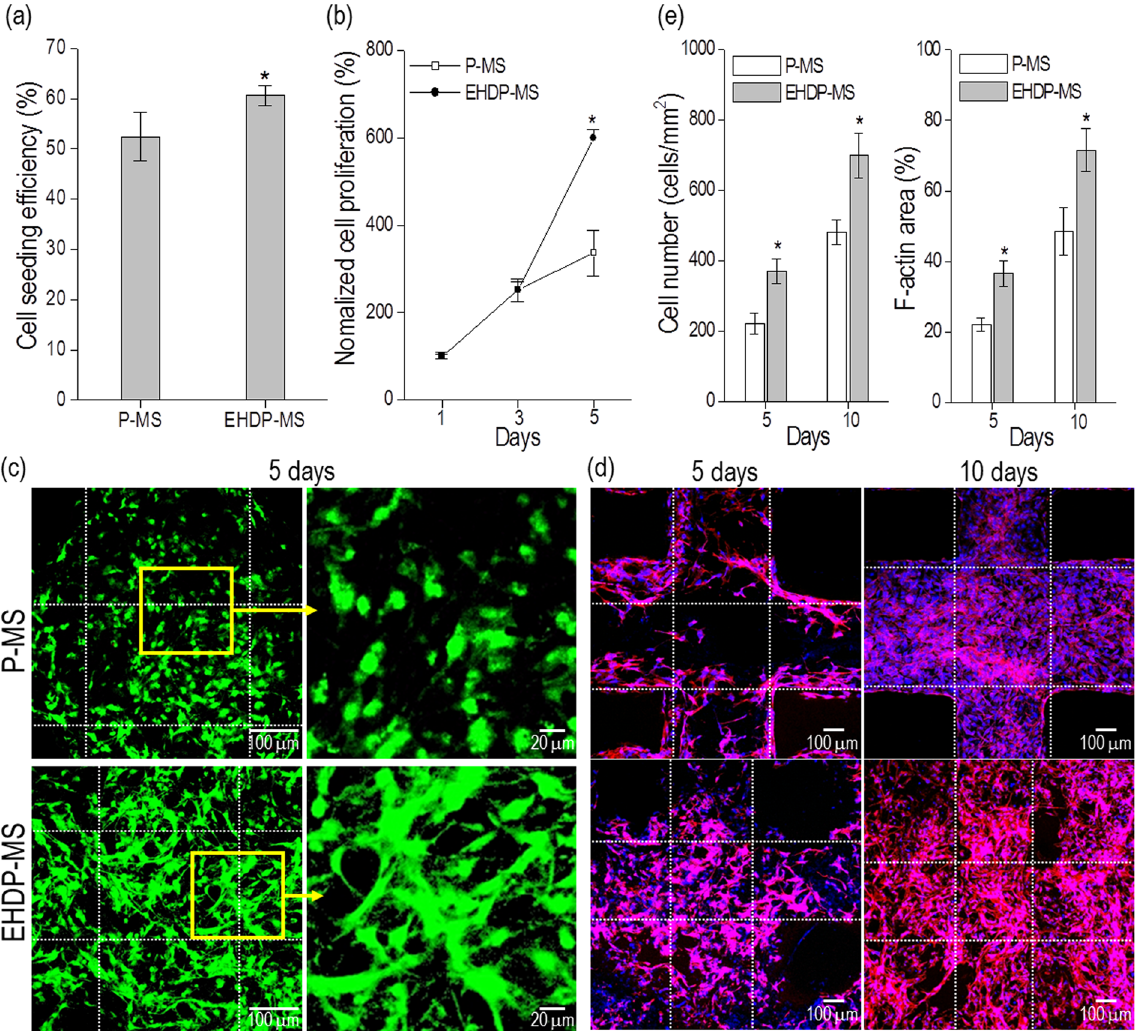
Figure 9. ( a ) Cell-seeding efficiently, ( b ) MTT result, ( c ) live/dead cells, and ( d ) DAPI/Phalloidin images of both structures (P-MS and EHDP-MS). ( e ) The number of nuclei and F-actin areas using DAPI/Phalloidin